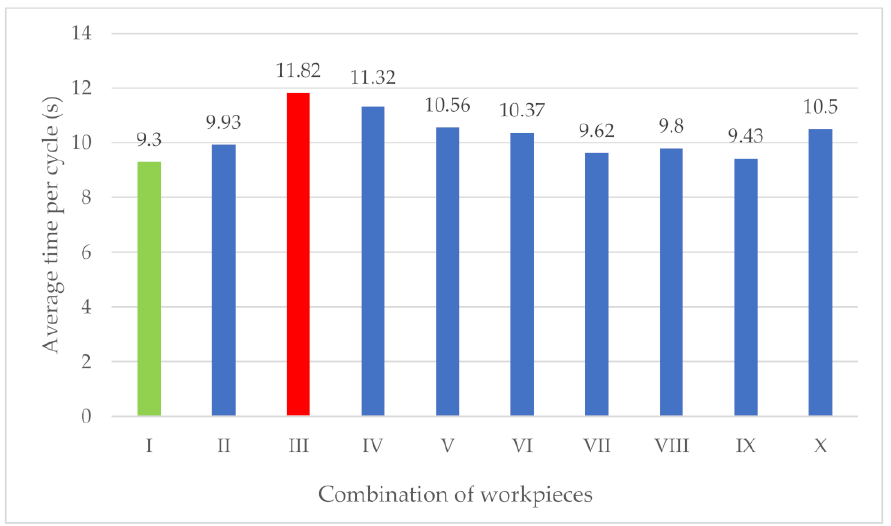
Figure 14. Average cycle time of the